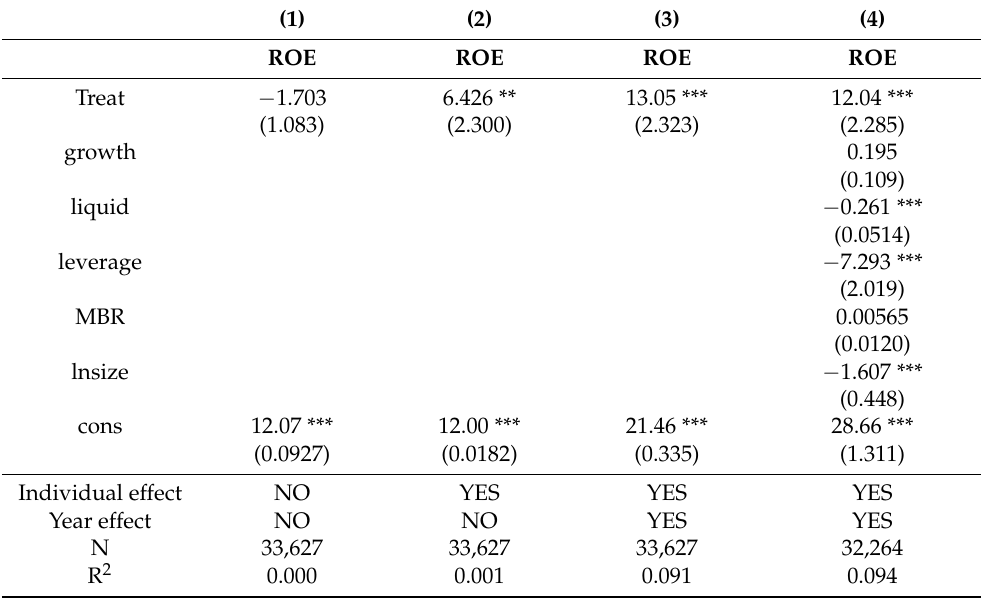
Table 3. DID estimates of the effectiveness of the de-capacity